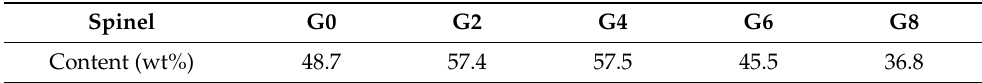
Table 3. Spinel content of different samples.